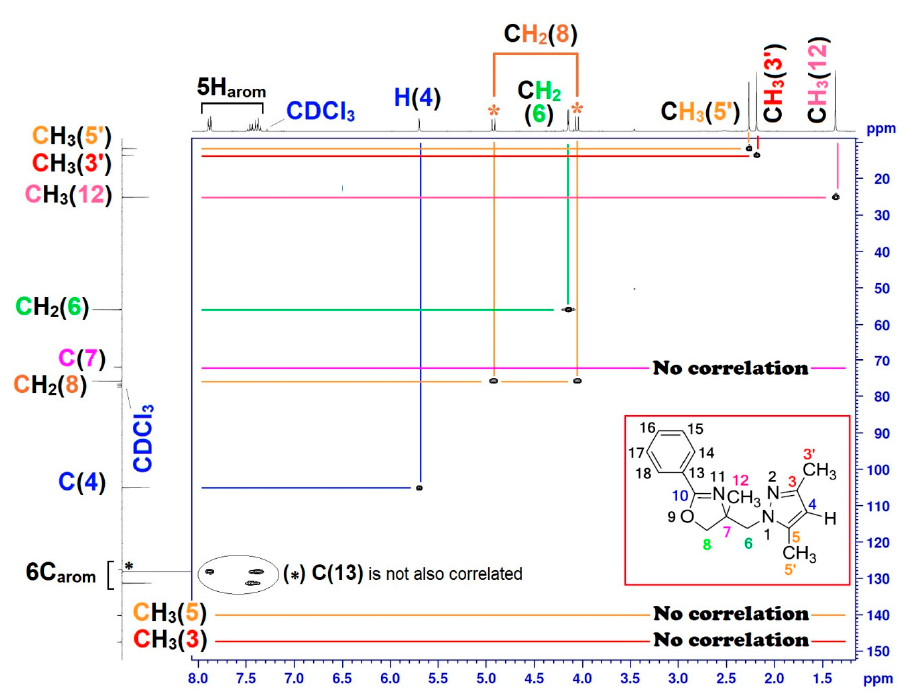
Figure 2. 1 H- 13 C 2D correlation spectroscopy identifies coupling between protons and carbons in compound 2 .